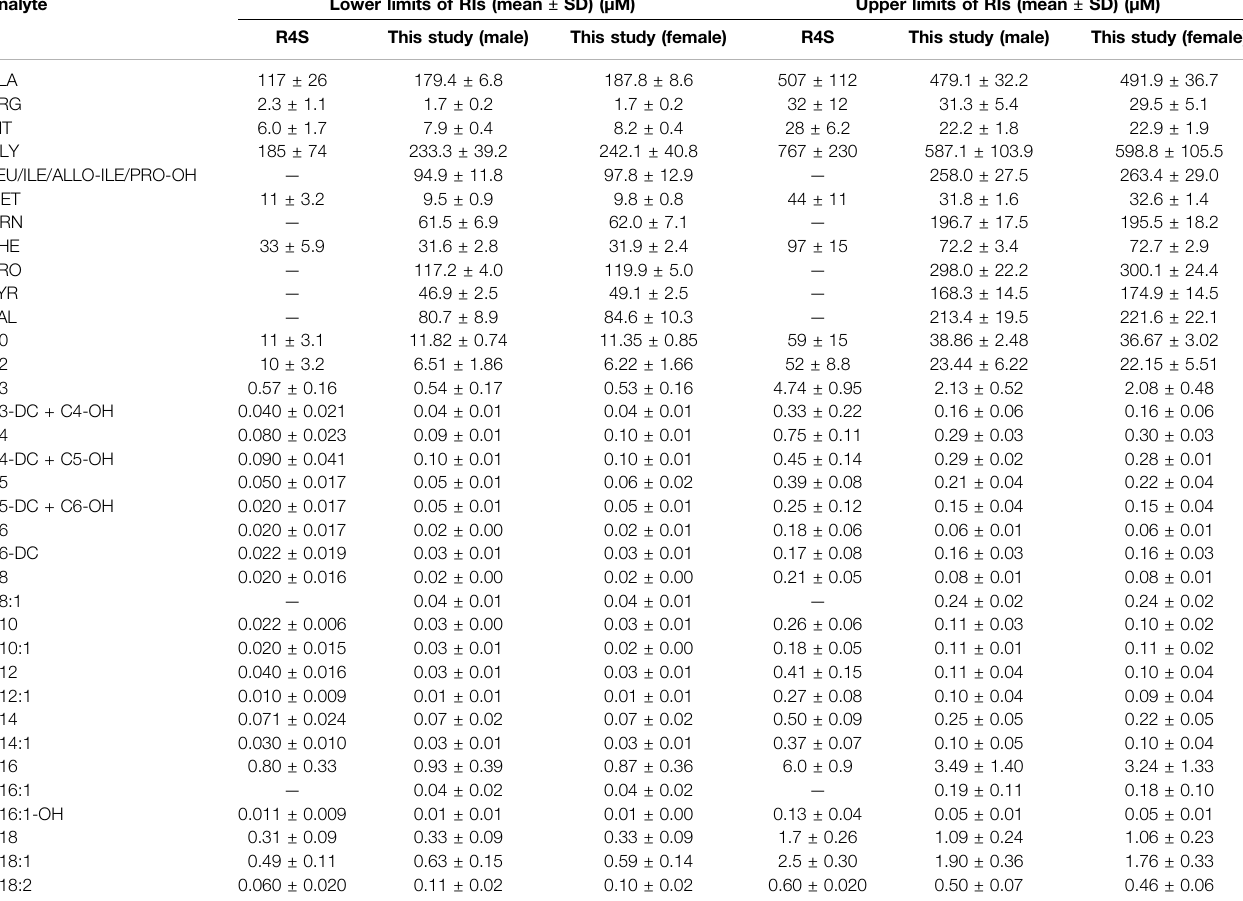
TABLE 3 | The RIs of R4S versus the RIs developed in this study. Analyte Lower limits of RIs (mean ± SD) ( μ M)